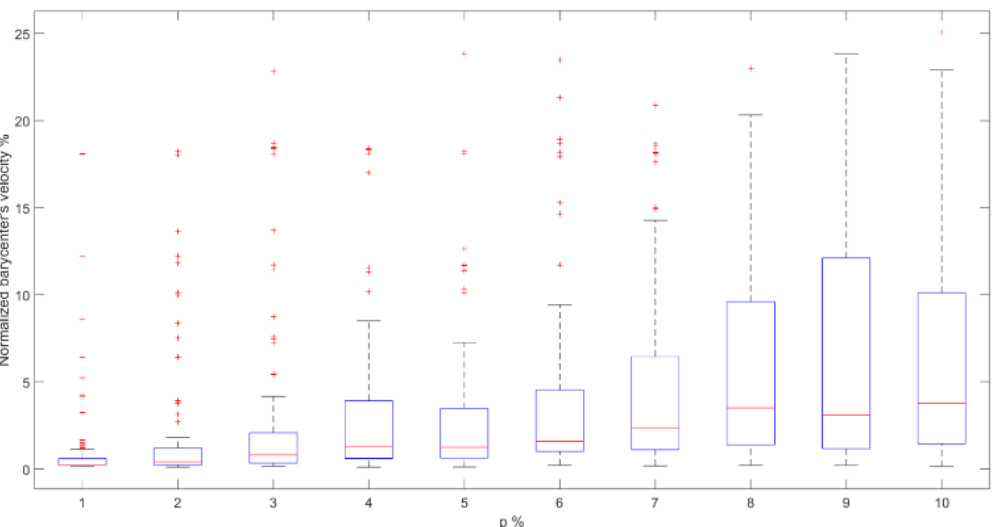
Figure 21. Boxplots of the statistical ensemble plotted versus the probability of long-range connections.